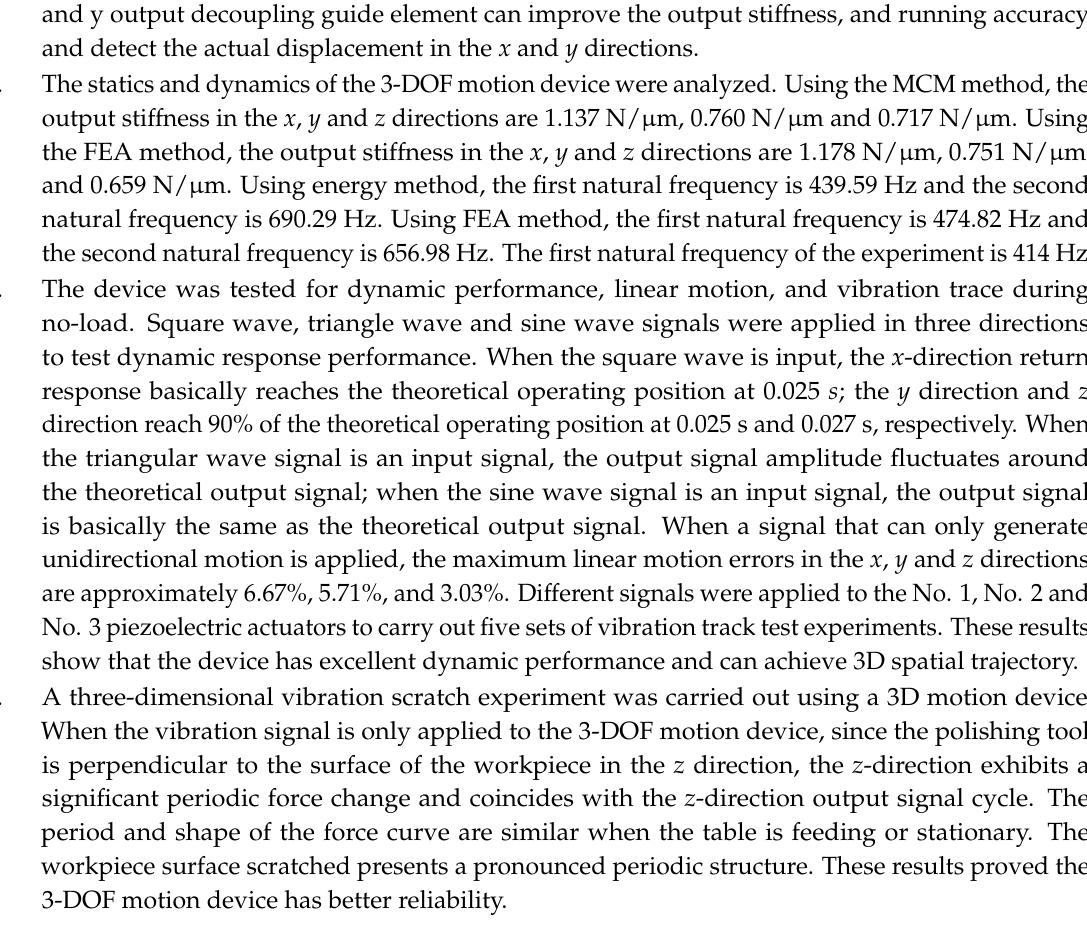
Figure S1: Structure and driving principle of force-dividing block, Figure S2: Force-dividing block input-output response, Figure S3: The displacement nephogram of FEA, Figure S4: 3D motion device structure. ( a ) 3D motion device structural solid model; ( b ) Structural combination model, Figure S5: Schematic diagram of output center error position, Figure S6: Circular flexure hinge, Figure S7: Beam flexure hinge, Table S1: The structure parameters and FEA results, Table S2: Correction coefficient k